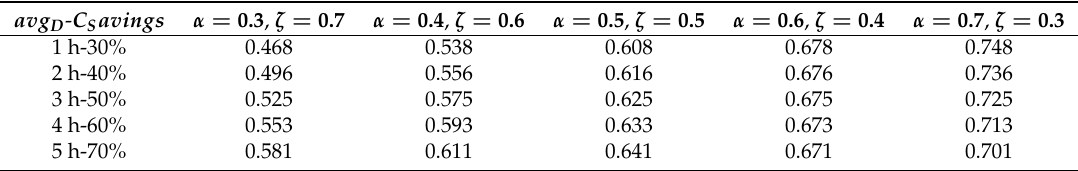
Table 4. UCL within different